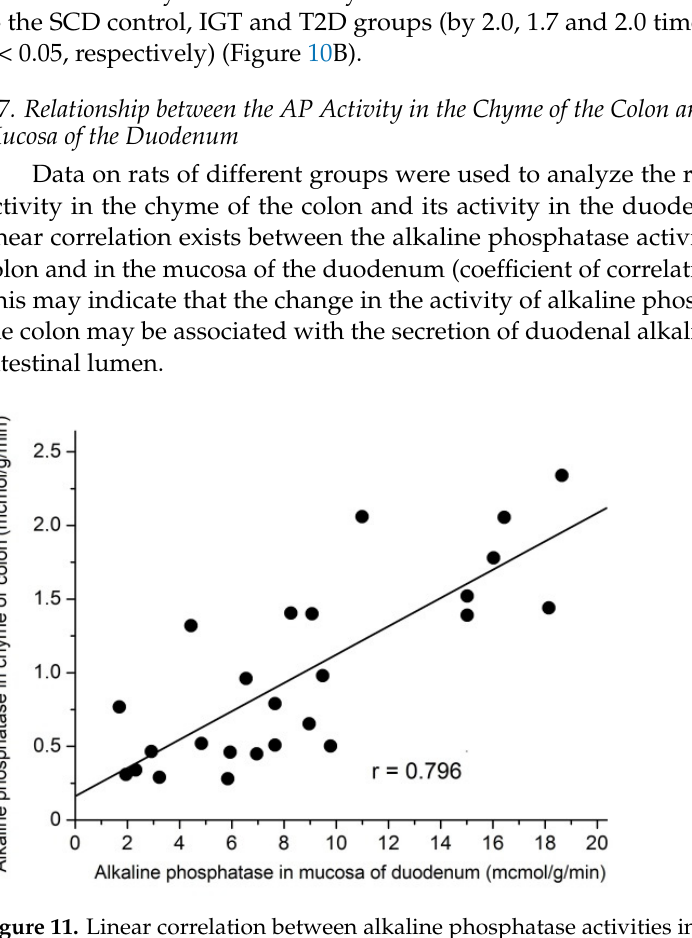
Figure 11. Linear correlation between alkaline phosphatase activities in jejunal mucosa and in the colon chyme. Coefficient of correlation r = 0.796 ( n = 25). The correlation was analyzed using Origin 7.0 (OriginLab Corporation, Northampton, MA, USA).